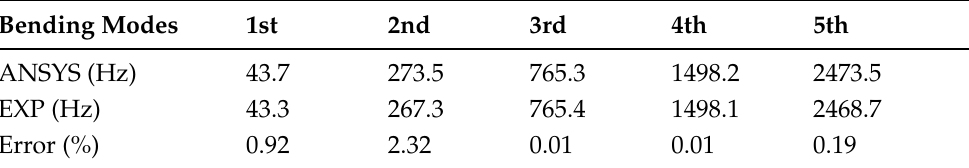
Table 5. Comparison results between the ANSYS and the experimental frequency values.